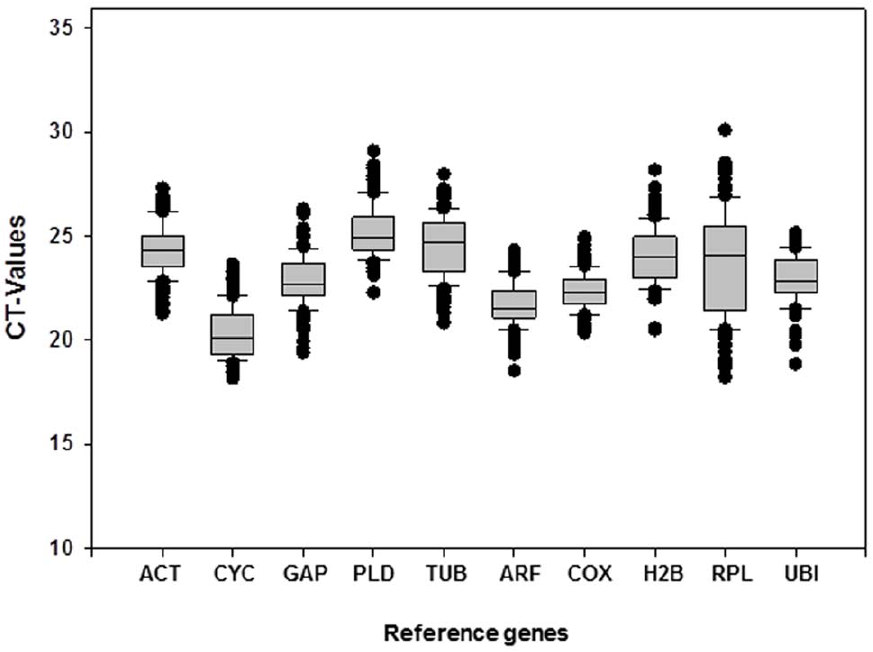
Figure 1. RT-qPCR CT values for the candidate reference genes. Expression data are displayed as CT values for each reference gene in all sweetpotato samples. Maximum and minimum CT values for each gene are